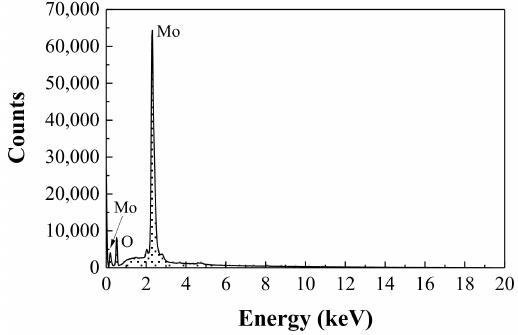
Figure 3. EDX analysis of the end product. Table 1. Estimated chemical composition of the end product. Data were obtained with EDX in semi-quantitative mode. The errors were automatically calculated by the analysis software. Element Series